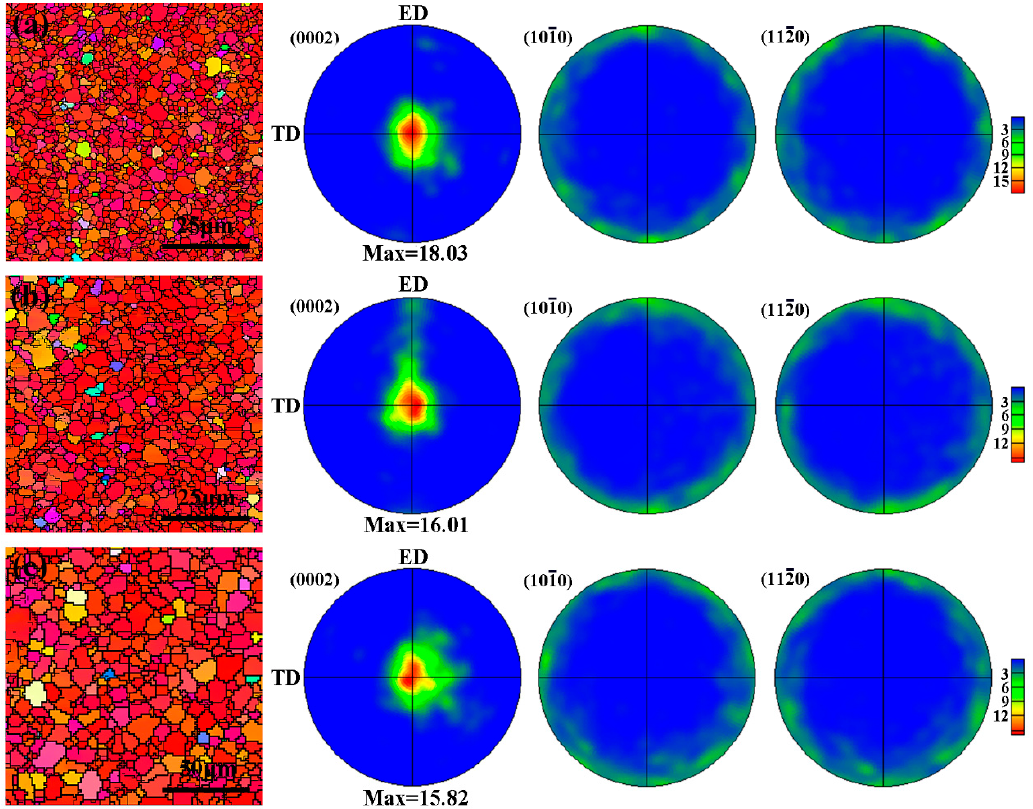
_ _ _ _ 10), (10 20) pole figures of the extruded sheets prepared by low- 010), (1 0 20) pole figures of the extruded sheets prepared by